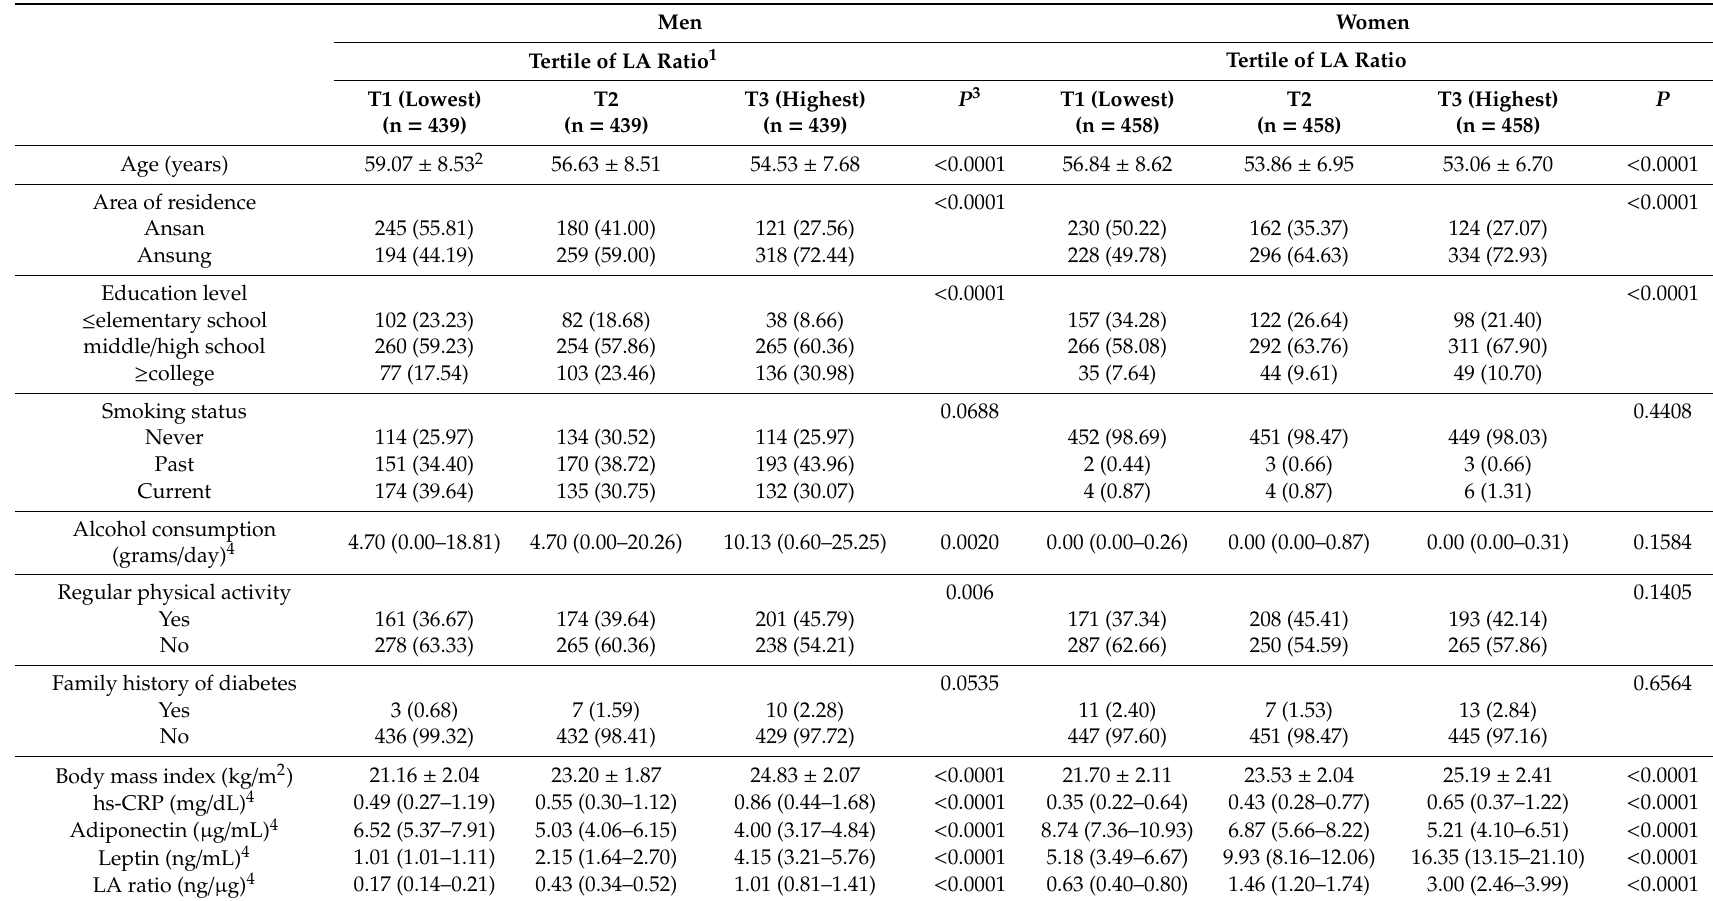
Table 1. Characteristics of the study participants according to leptin-adiponectin ratios in Korean men and women aged 45–76